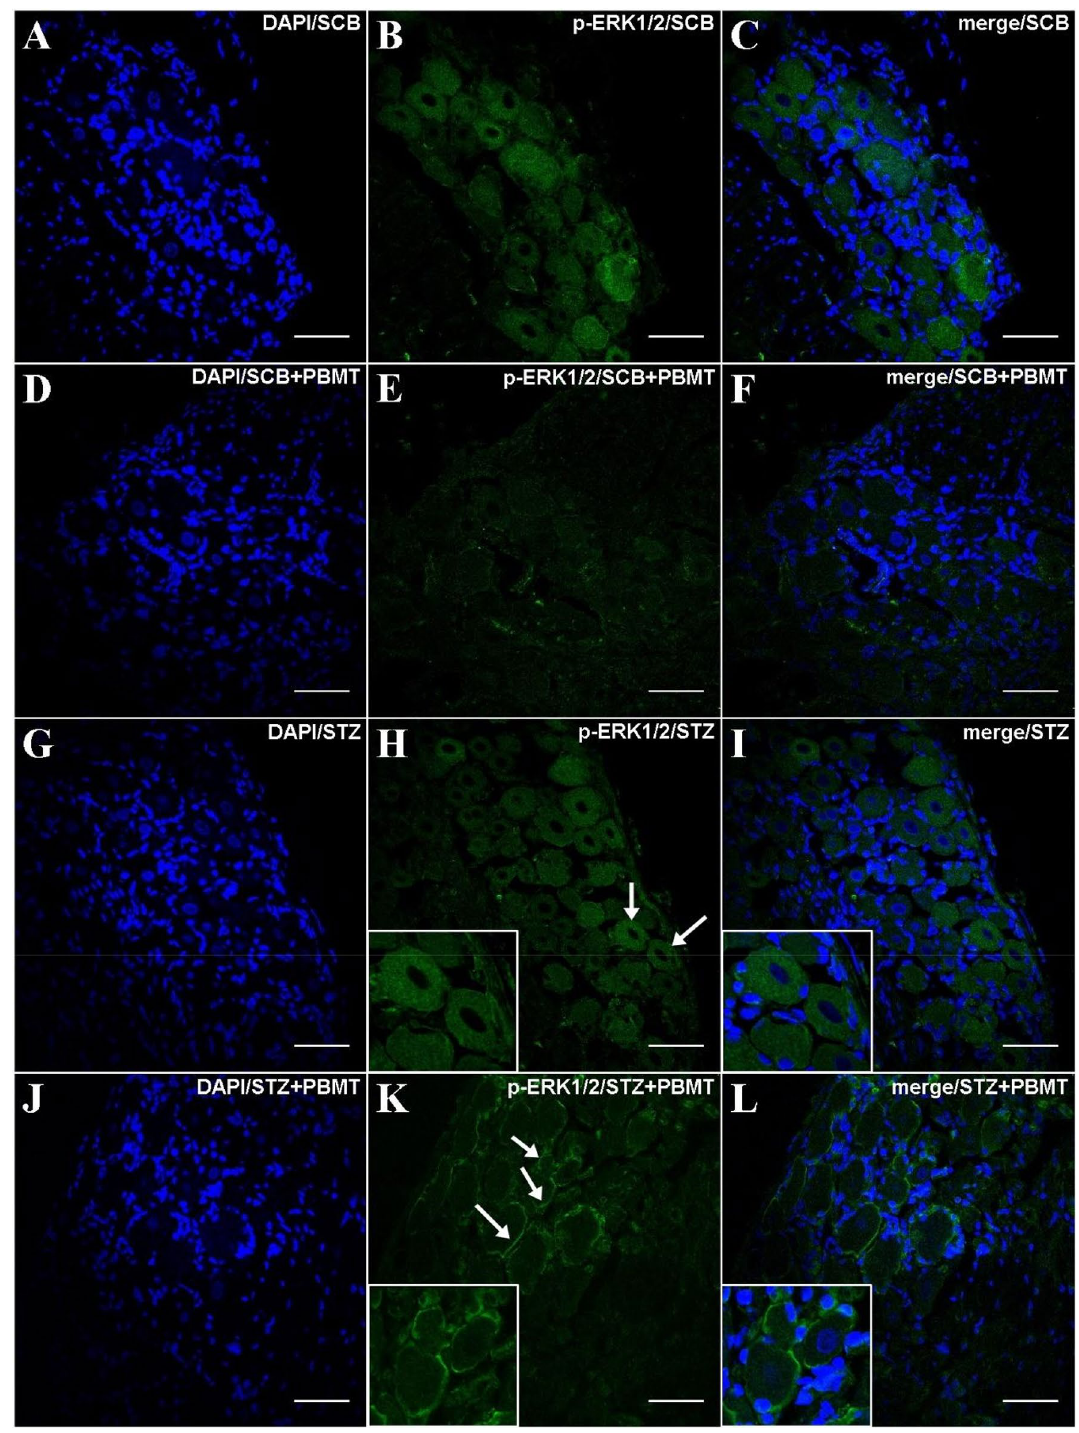
Figure 6. DRG histological micrographs of p-ERK1/2 MAPK by confocal microscopy. DRG transversal 14 µm-thick sections submitted to IF protocol for staining ERK1/2 phosphorylation in Thr202 and Tyr204 (p44/ p42) ( B , E , H , K ). DAPI for nuclear staining is shown in ( A , D , G , J ). Images of merge (DAPI + p-ERK1/2) are also shown in ( C , F , I , L ). In ( H ) and ( K ), white arrows point to the zoomed-in areas. Details are shown in the left corner of ( H , I , K , L ). Magnification: ×40; scale bars: 50